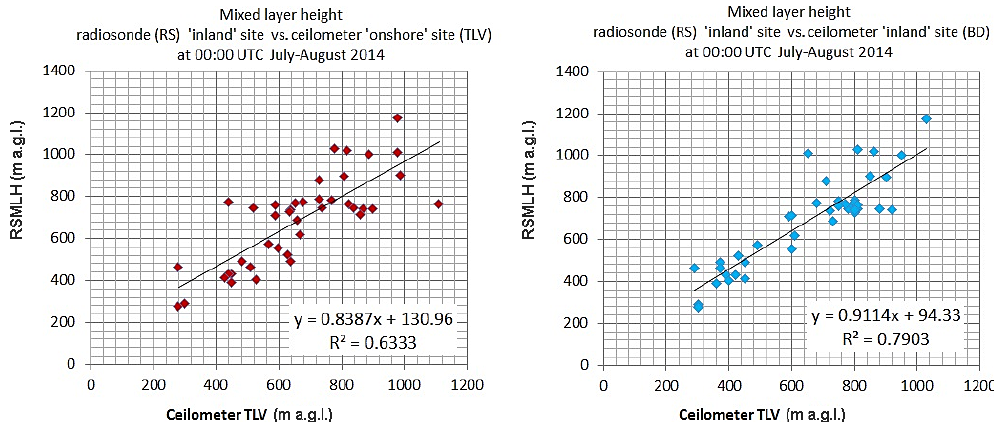
Figure 10. Correlation values between MLH from radiosonde (RS) profiles at 00:00UTC, the onshore Tel Aviv (TLV) ceilometer, and the